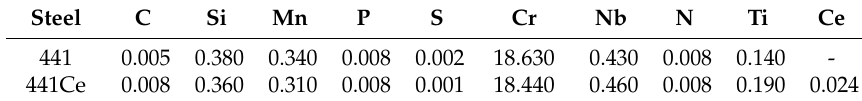
Table 1. Chemical compositions of test materials (wt%).